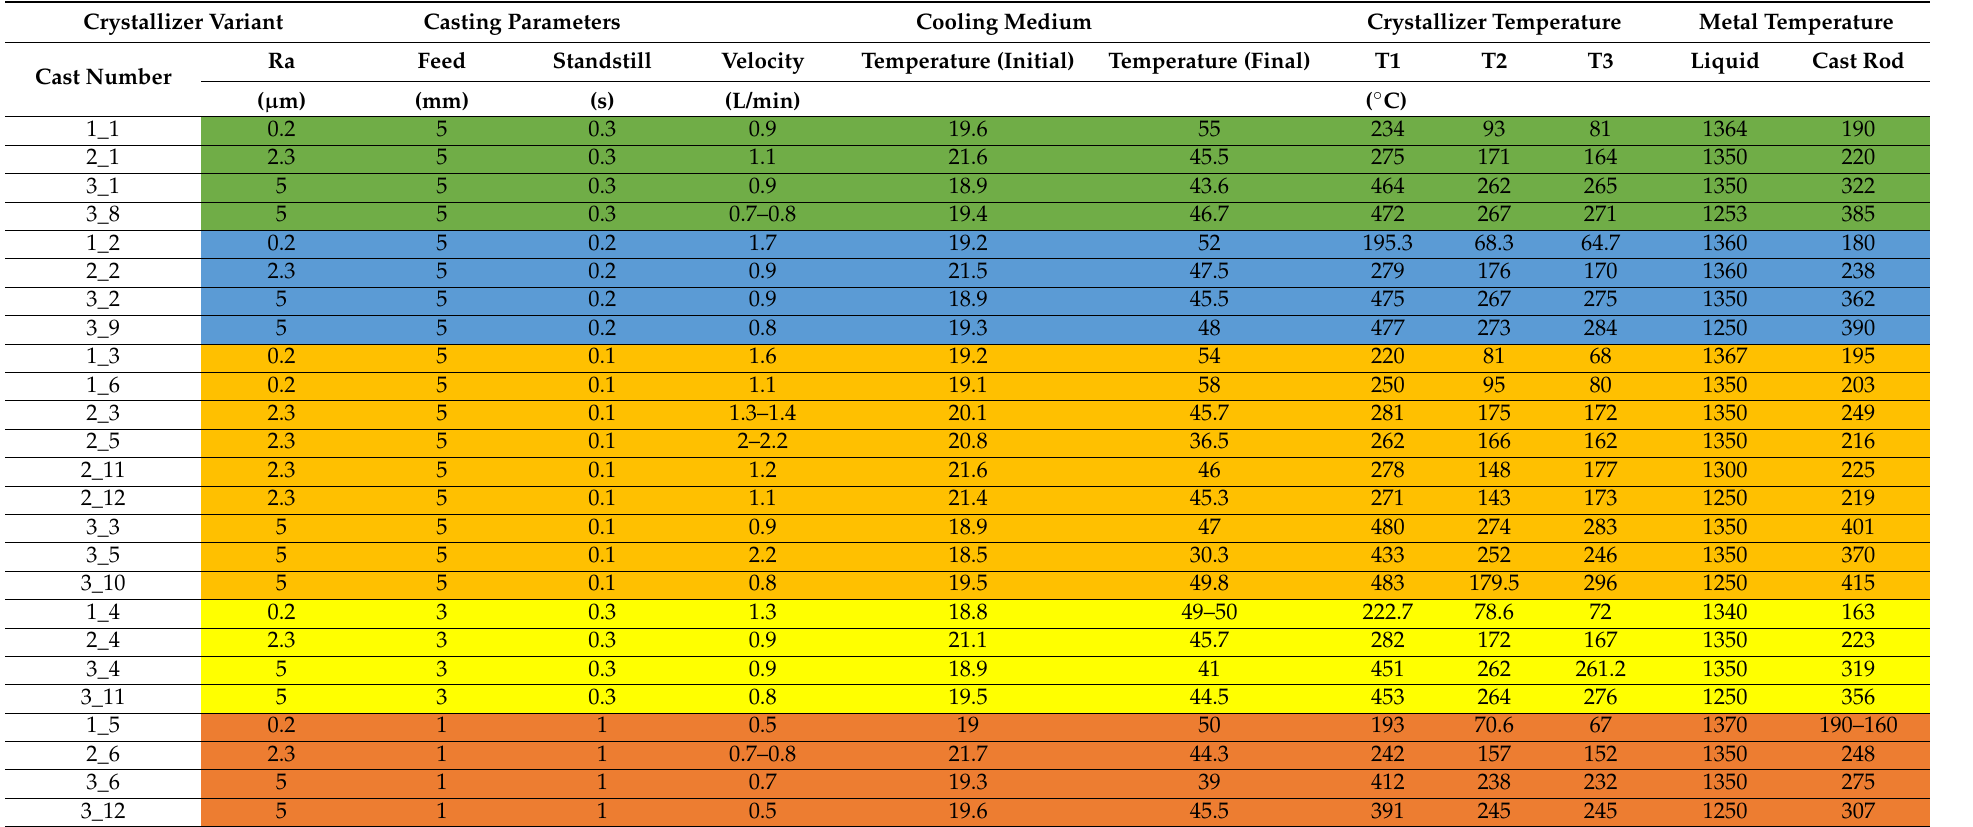
Table 2. Collective data measured throughout the laboratory continuous casting